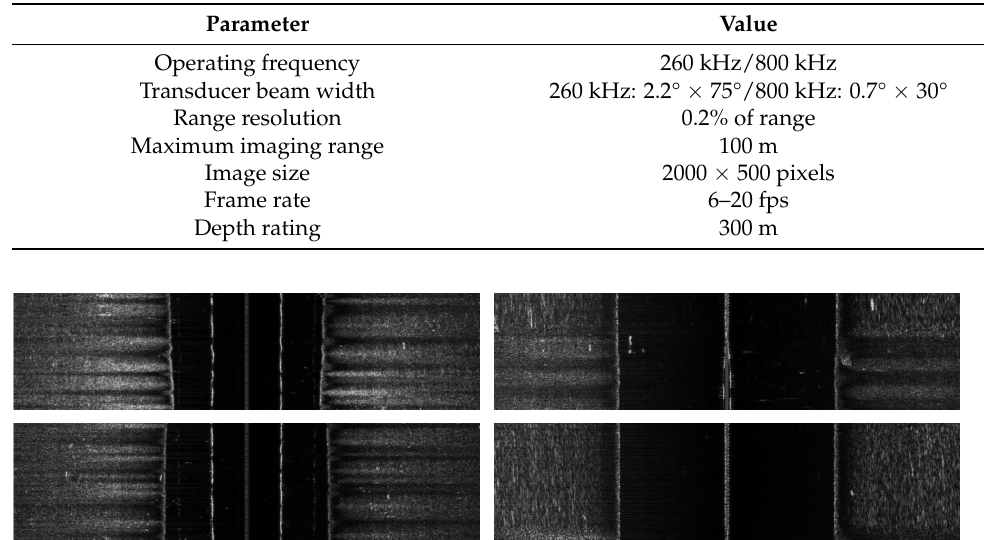
Table 1. Specifications of the side-scan sonar.